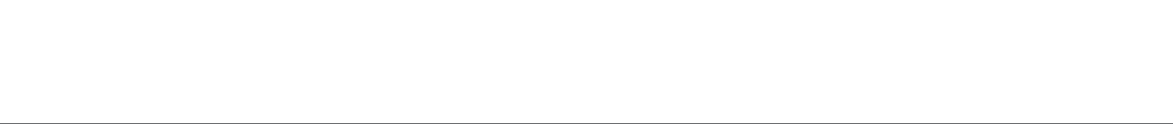
Frontiers in Astronomy and Space Sciences |